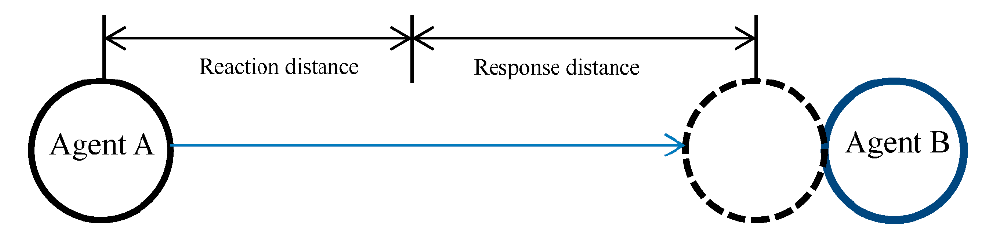
Figure 5. Reaction and response